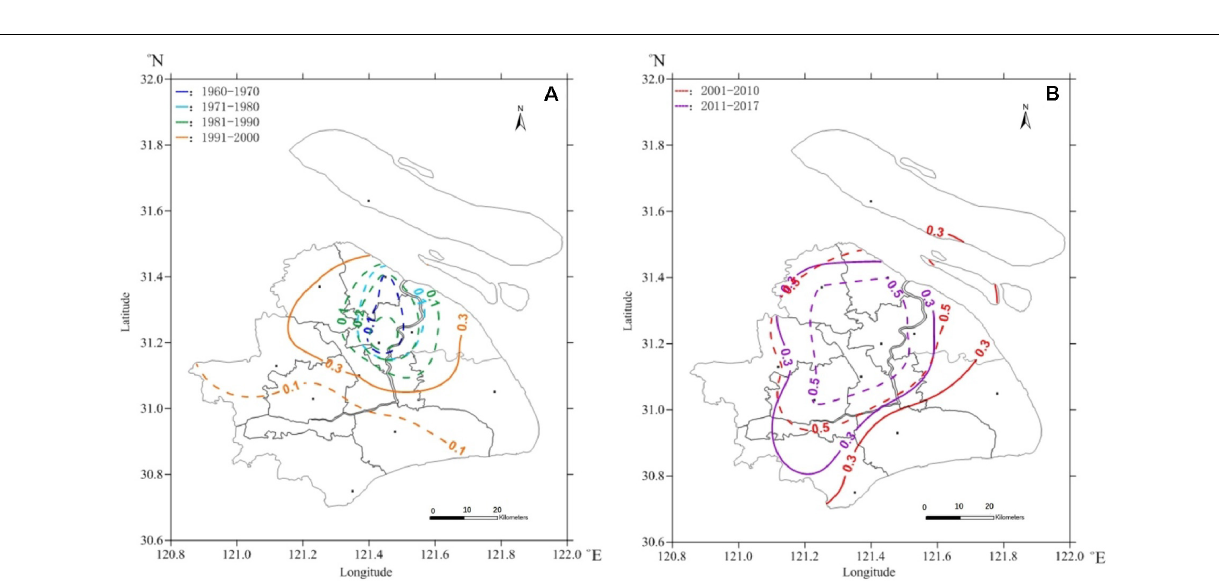
Frontiers in Earth Science |